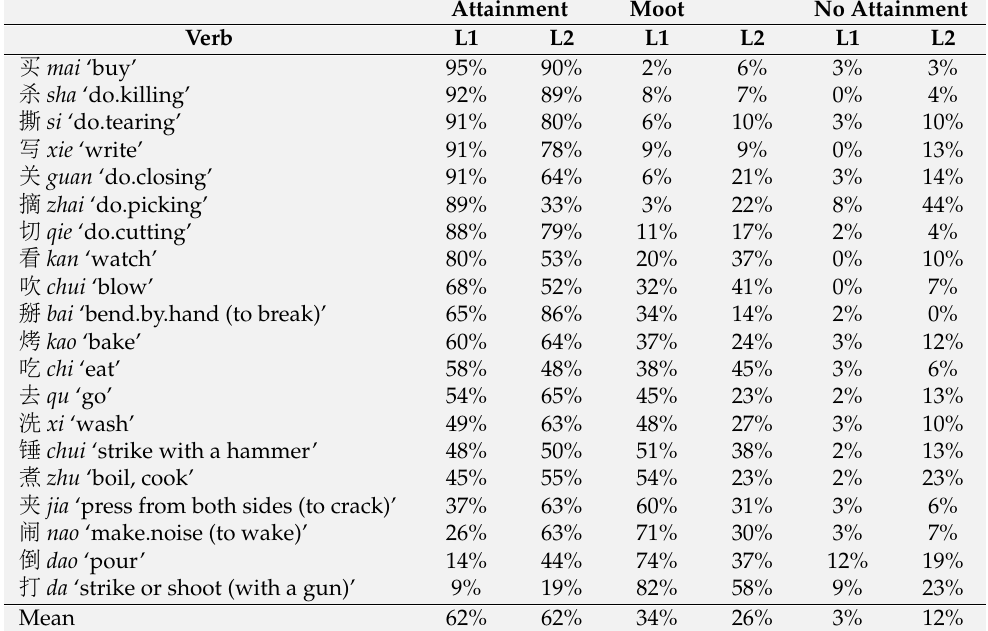
Table 5. Mean proportions of choices of state-change attainment by verb and